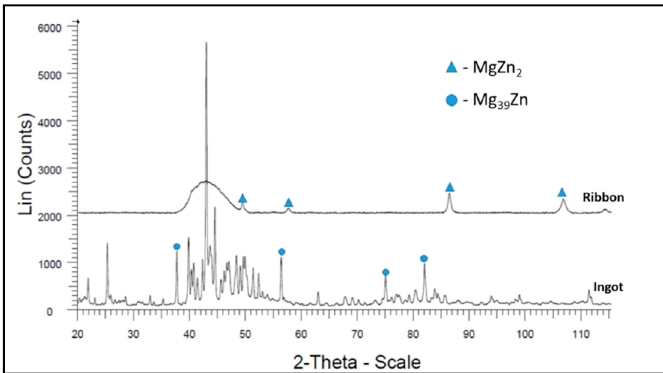
Figure 3. Light microscope image of microstructure revealed after etching in 2% nital solution for Zn 87 Mg 9 Ca 4 bulk material sample—before the melt spinning process.